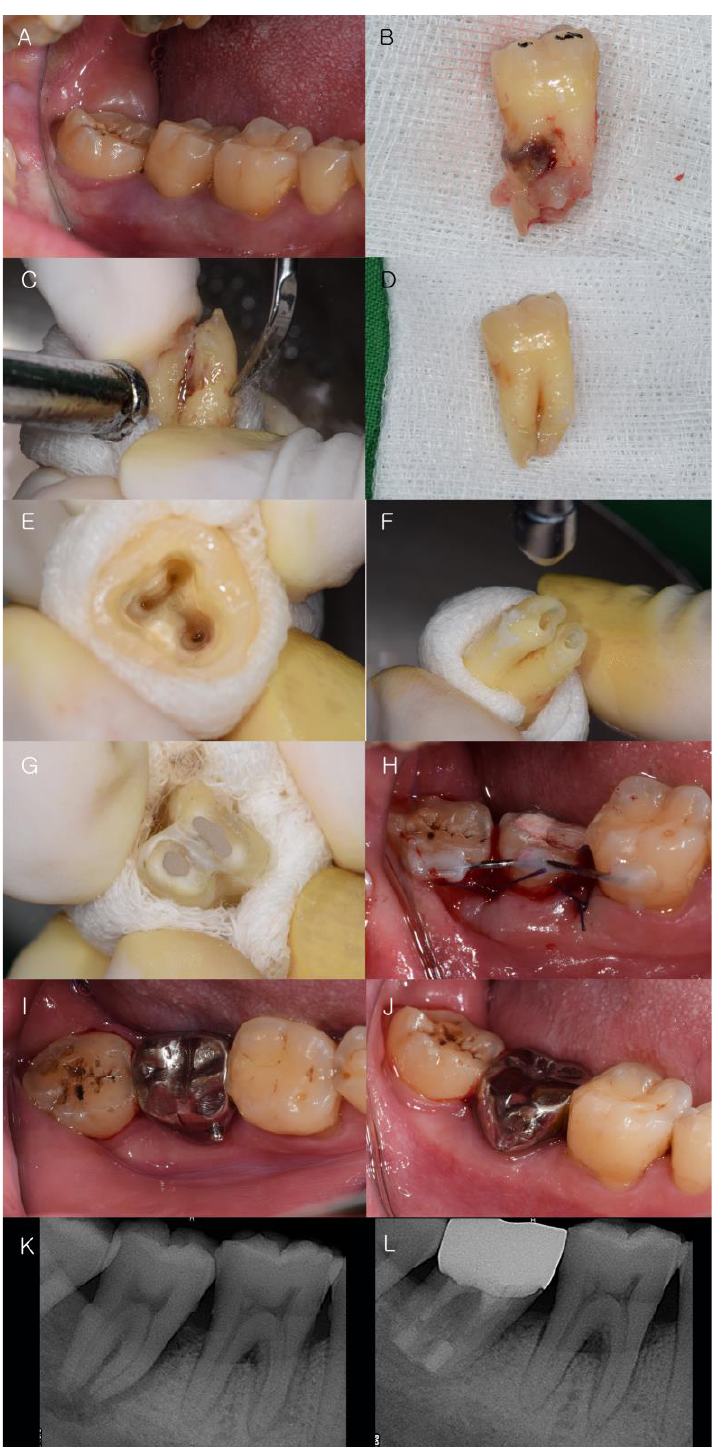
Figure 3. Surgical procedure of IR. ( A – D ) The tooth was extracted with atraumatic force. Granula- tion tissue and calculus on root surface were removed; ( E – G ) A 3-mm root-end preparation was achieved. Retrograde filling was performed with MTA and 4-META/MMA-TBB dentin-bonded resin; ( H – J ) The tooth was splinted with the adjacent teeth for 12 weeks. Prosthetic restoration was made after 3 months; ( K , L ) The radiographic images before and after IR. IR: intentional replantation, MTA: mineral trioxide aggregate, 4-META/MMA-TBB: The 4-methacryloxyethyl trimellitate anhy- dride/methyl methacrylate-tri-n-butylborane.